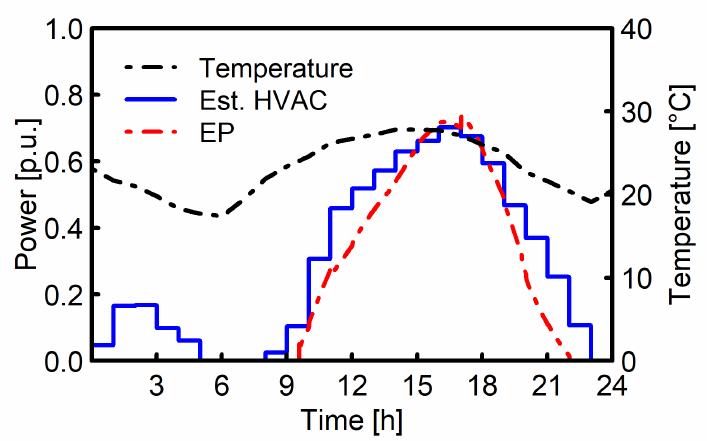
Figure 14. Example day variations for the HVAC power component at community level disaggregated with the proposed ML method and scaled up from an EnergyPlus model of a representative